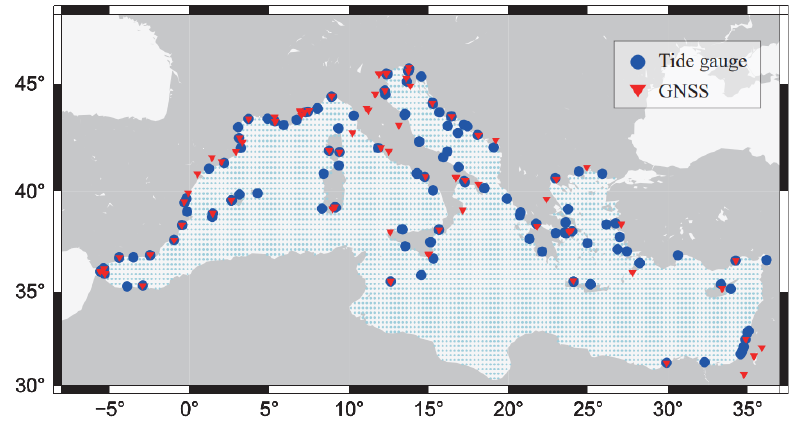
Figure 1. The distribution of initial tide gauge stations (blue dots) and GNSS stations (red trian-